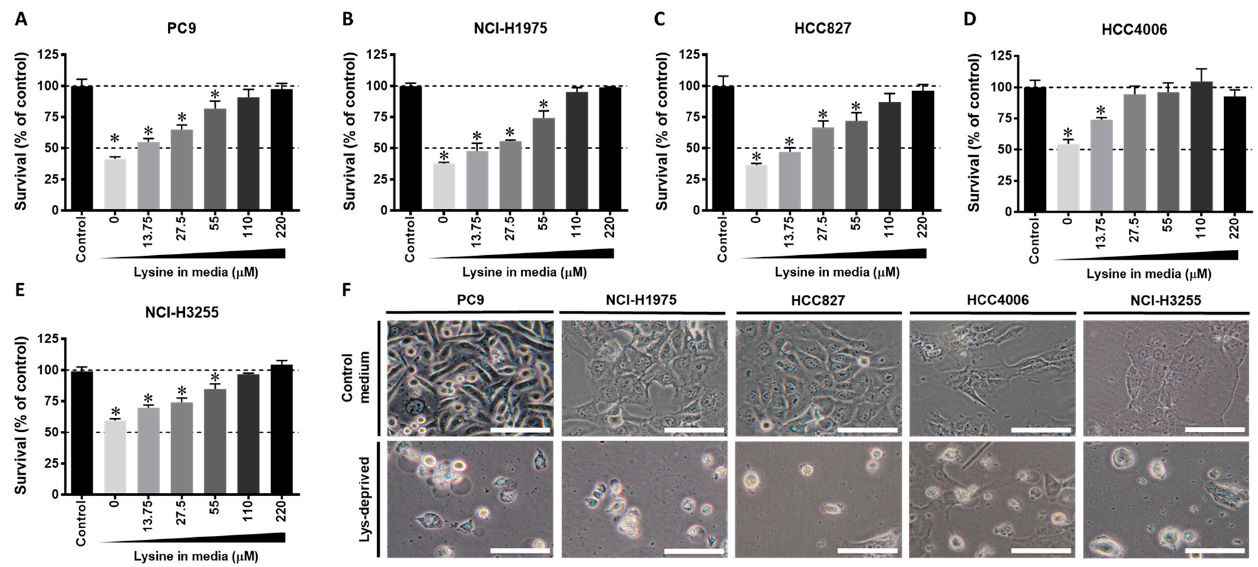
Figure 3. The effects of lysine reduction on EGFR -mutant NSCLC cells. ( A ) PC9, ( B ) NCI-H1975, ( C ) HCC827, ( D ) HCC4006, and ( E ) NCI-H3255 cells were incubated in culture media at a series of lysine concentrations for 48 h, and their survival was analyzed using an SRB assay. ( F ) EGFR -mutant NSCLC cells were incubated with a lysine-deprived media for 48 h, and representative images of the morphology were obtained using a light microscope (scale bar: 100 μ m). The SRB analysis results shown are representative of three independent experiments. SRB, Sulforhodamine B. The data are presented as the mean ± SEM (*, p < 0.05 compared with the control).